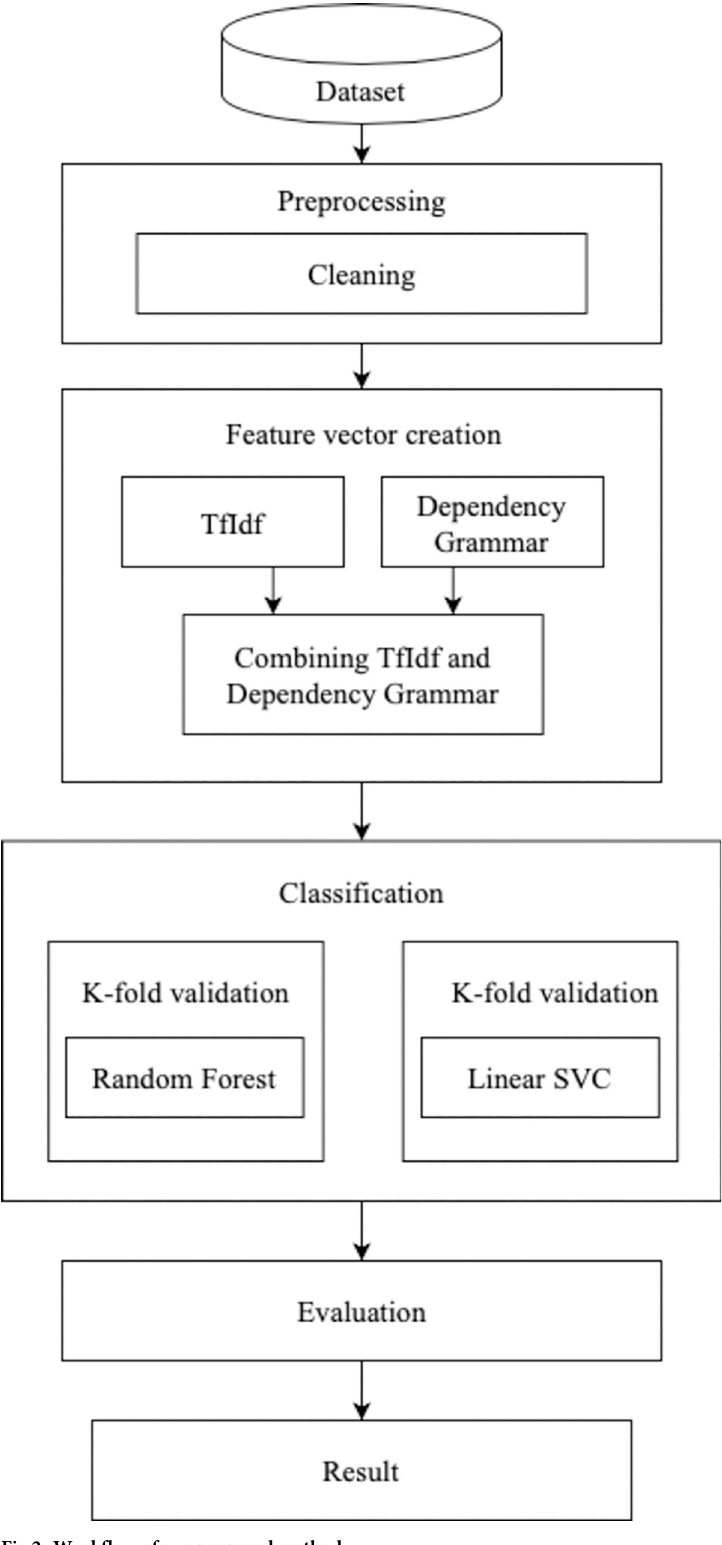
Fig 2. Workflow of our proposed